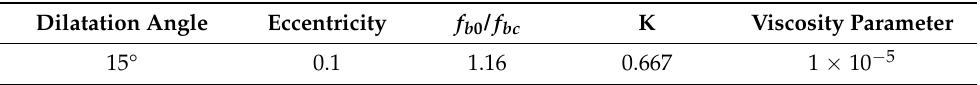
Table 2. Parameters of the concrete damage plasticity constitutive model.